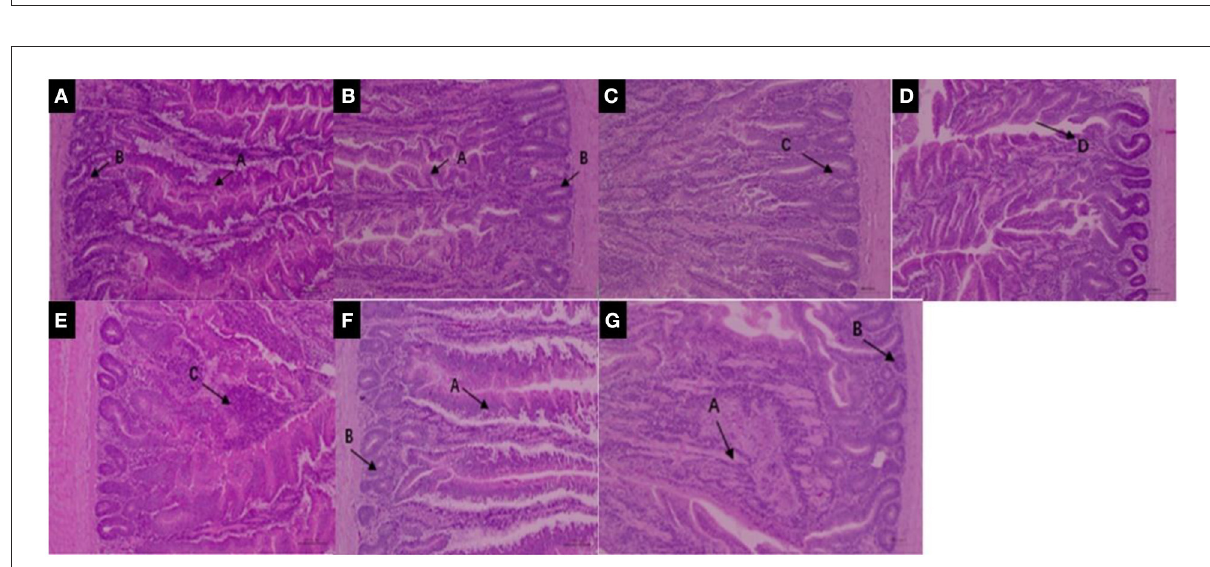
FIGURE3 (A–D) Duodenum structure under 100 × magnification during deltamethrin treatment for 0 (A) , the 1st (B) , 7th (C) , and 14th day (D) . (E–G) Duodenum structure under 100 × magnification at the 1st (E) , 7th (F) , and 14th day (G) during deltamethrin treatment withdrawal. A, intestinal villi; B, intestinal glands (intestinal crypts); C, local mucosal lymphocyte infiltration; D, absence of intestinal villi